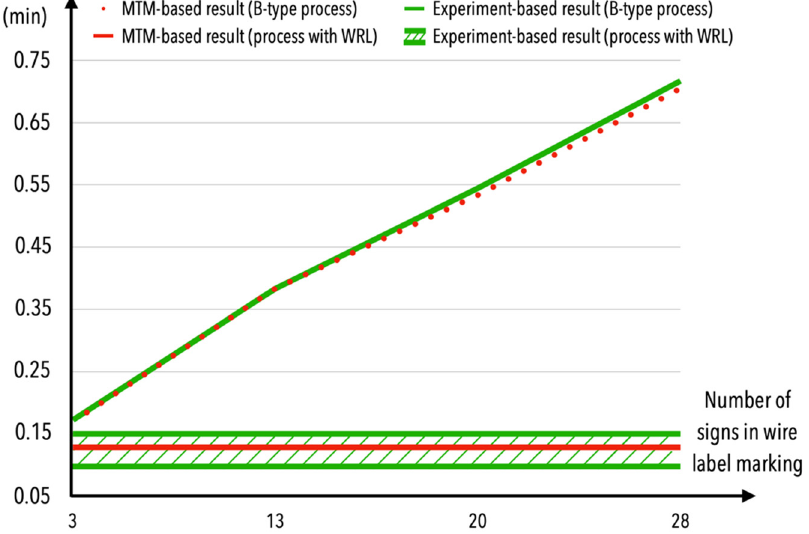
Figure 19. Comparison of the results obtained with and without the use of the WLR in the assembly process. bly process.